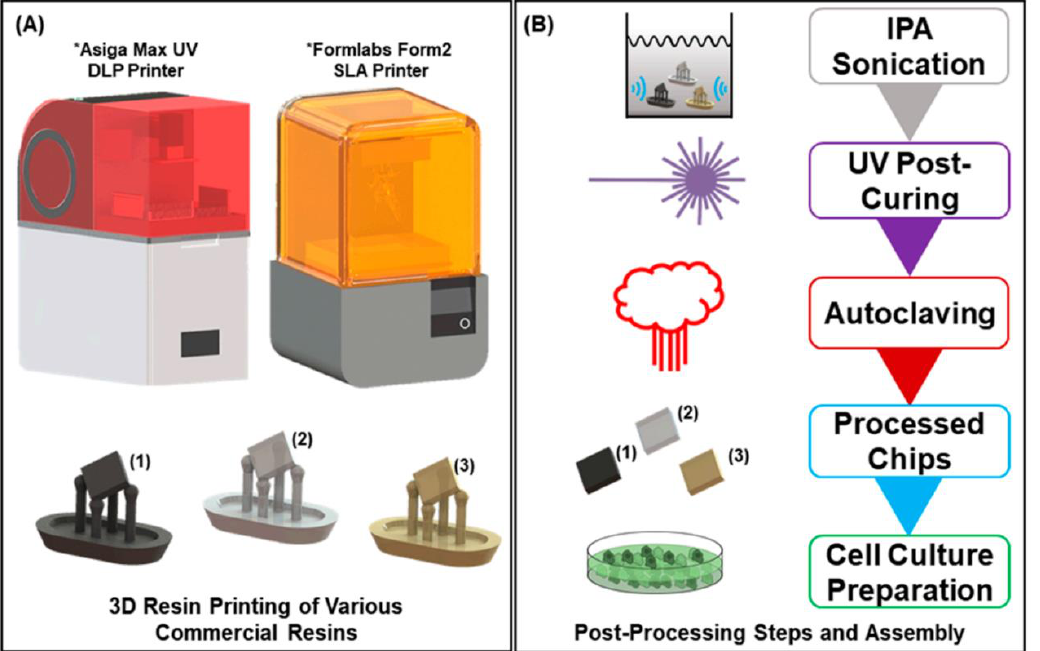
Figure 8. Resin chip fabrication: ( A ) schematic of the Asiga Max UV digital light processing (DLP) 3D printer and the Form2 stereolithography (SLA) 3D printer and associated printed resin chips (flexible resin in black (1), clear resin/high-temp resin in grey (2), and dental resin in brown(3)). The printer can cure many different commercial methacrylate-based photopolymer resins, allowing for a variety of sampling materials, provided that the photoinitiator absorbs between 385 and 405 nm. Each chip comes printed on a raft and support structure (as shown in the schematic) and must be singulated before post-processing. ( B ) Resin chip post-processing stages. Each of the indicated steps as well as the order was the final sequence used for a full regimen of resin treatment. After full post-processing, the chips can then be assembled in 48-well plates and sterilized for cell culture. Reproduced with permission from Hart et al. [3], Biosensors, 10, 152. Published by MDPI,